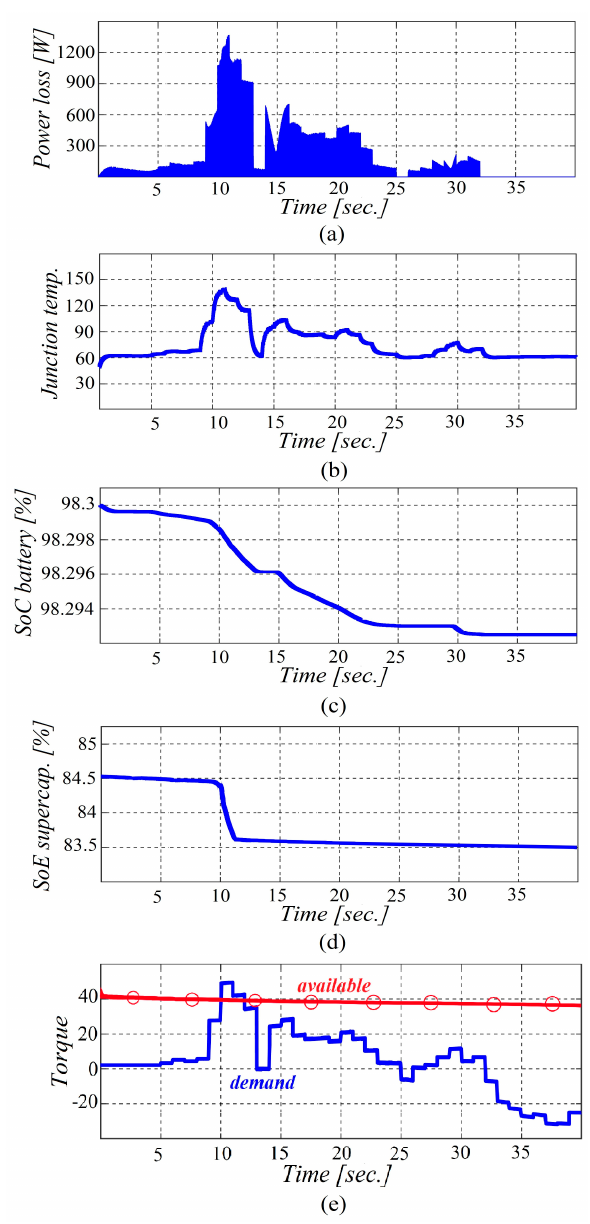
Figure 10. Simulation results without the utilization of the proposed recommender system (when the driver rejects the request of the recommender system) ( a ) Total power losses of the IGBT module (one switch) ( b ) Estimated junction temperature ( c ) Estimated battery SoC ( d ) Estimated supercapacitor SoC ( e ) Available and demanded tractive torque.